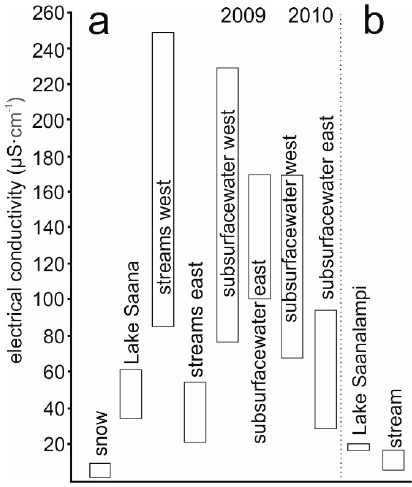
Figure 5. Values of electrical conductivity in streams and subsurface water on the catchments of lakes Saana ( a ) and Saanalampi catchment ( b ).